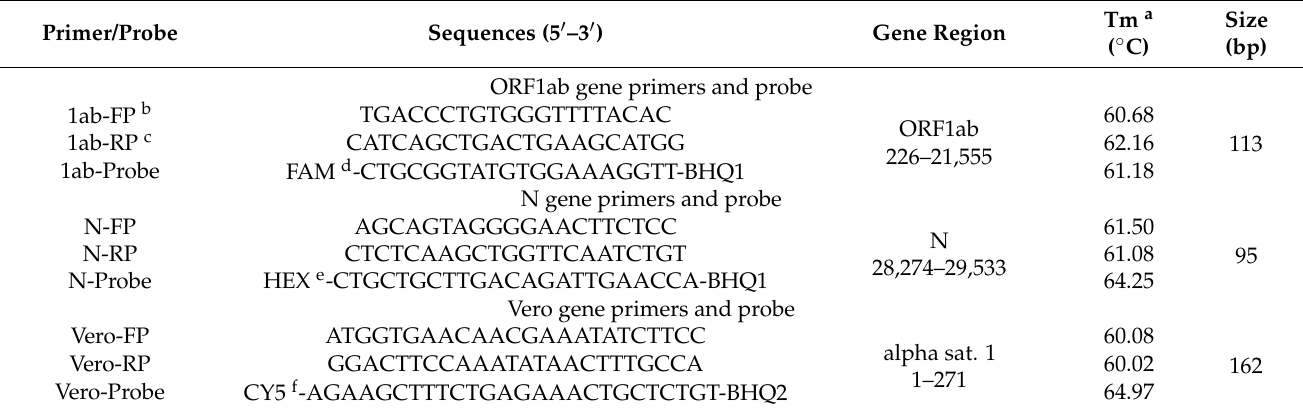
Table 1. Primers and probes used for the RT-qPCR